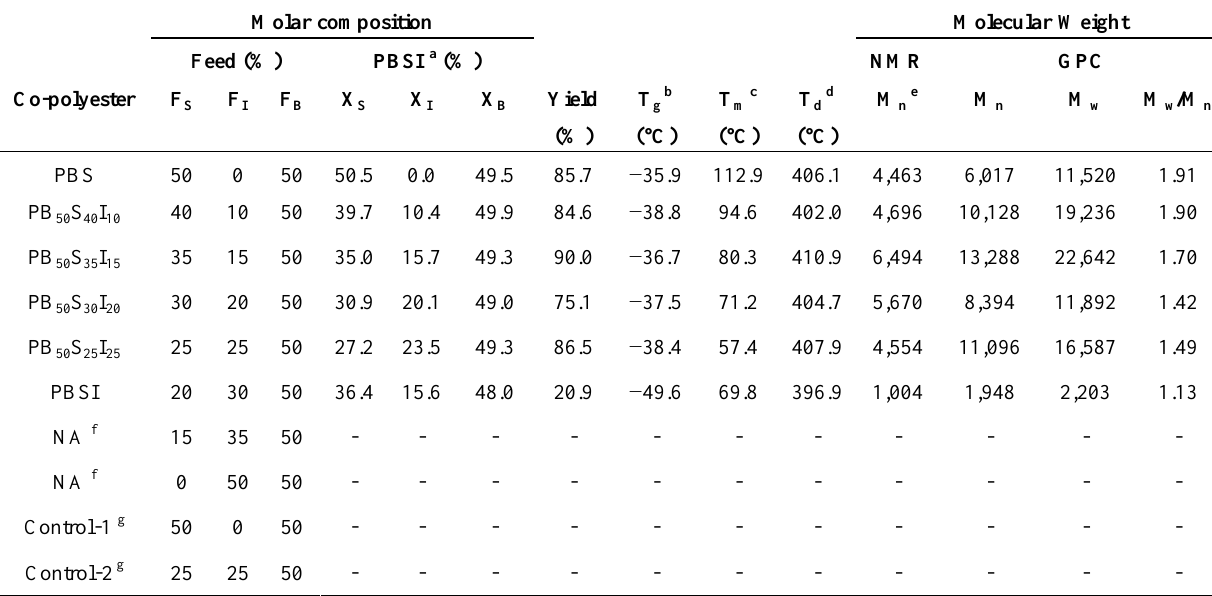
Table 4. Summary of the results for the CALB-catalyzed synthesis of PBS and PBSI. Molar composition Molecular